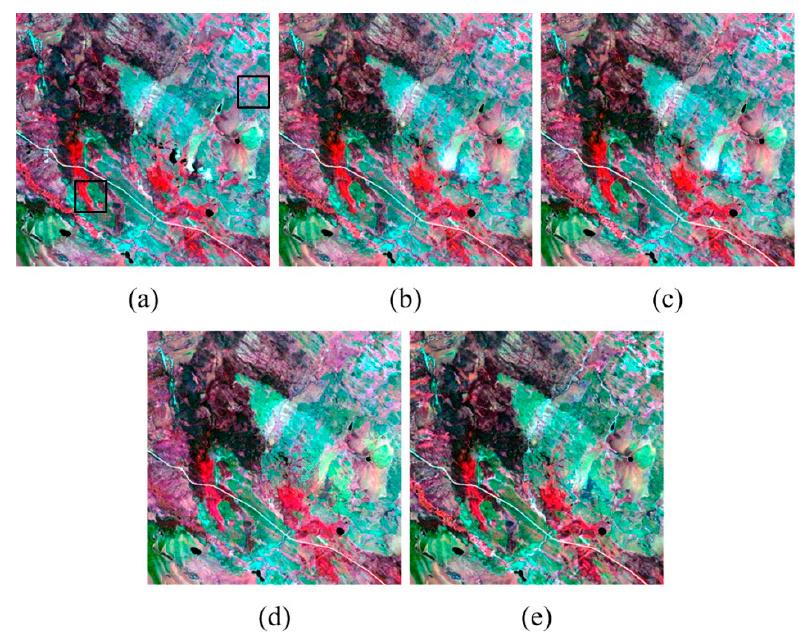
Figure 3. The ( a ) actual image acquired on 11 July 2001 and its predictions by ( b ) STBDF-I (Spatio-Temporal Bayesian Data Fusion I), ( c ) STBDF-II, ( d ) STARFM (Spatial and Temporal Adaptive Reflectance Fusion Model), and ( e ) ESTARFM (enhanced STARFM).